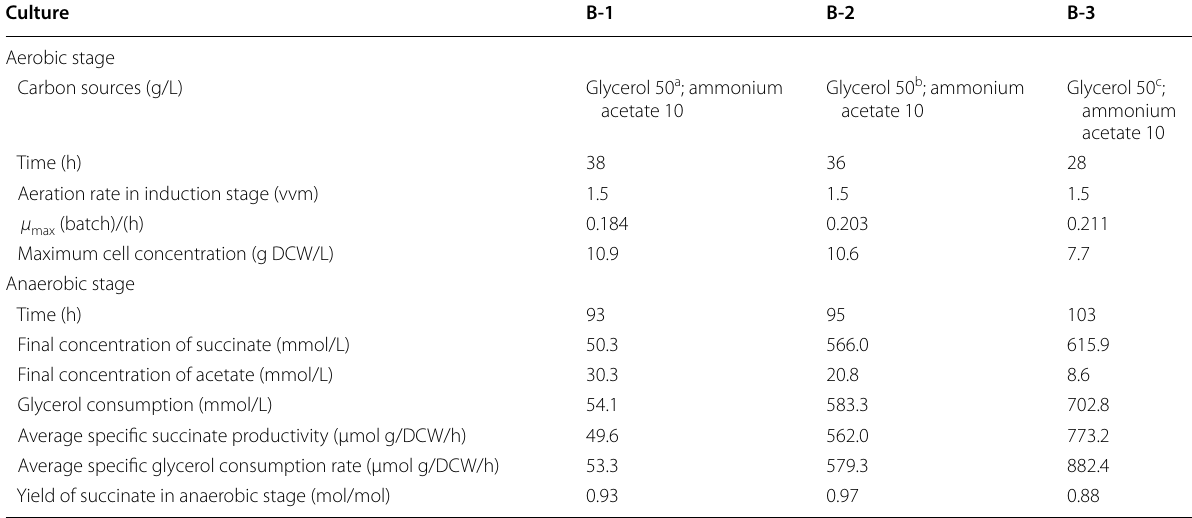
The anaerobic stage lasted 72 h